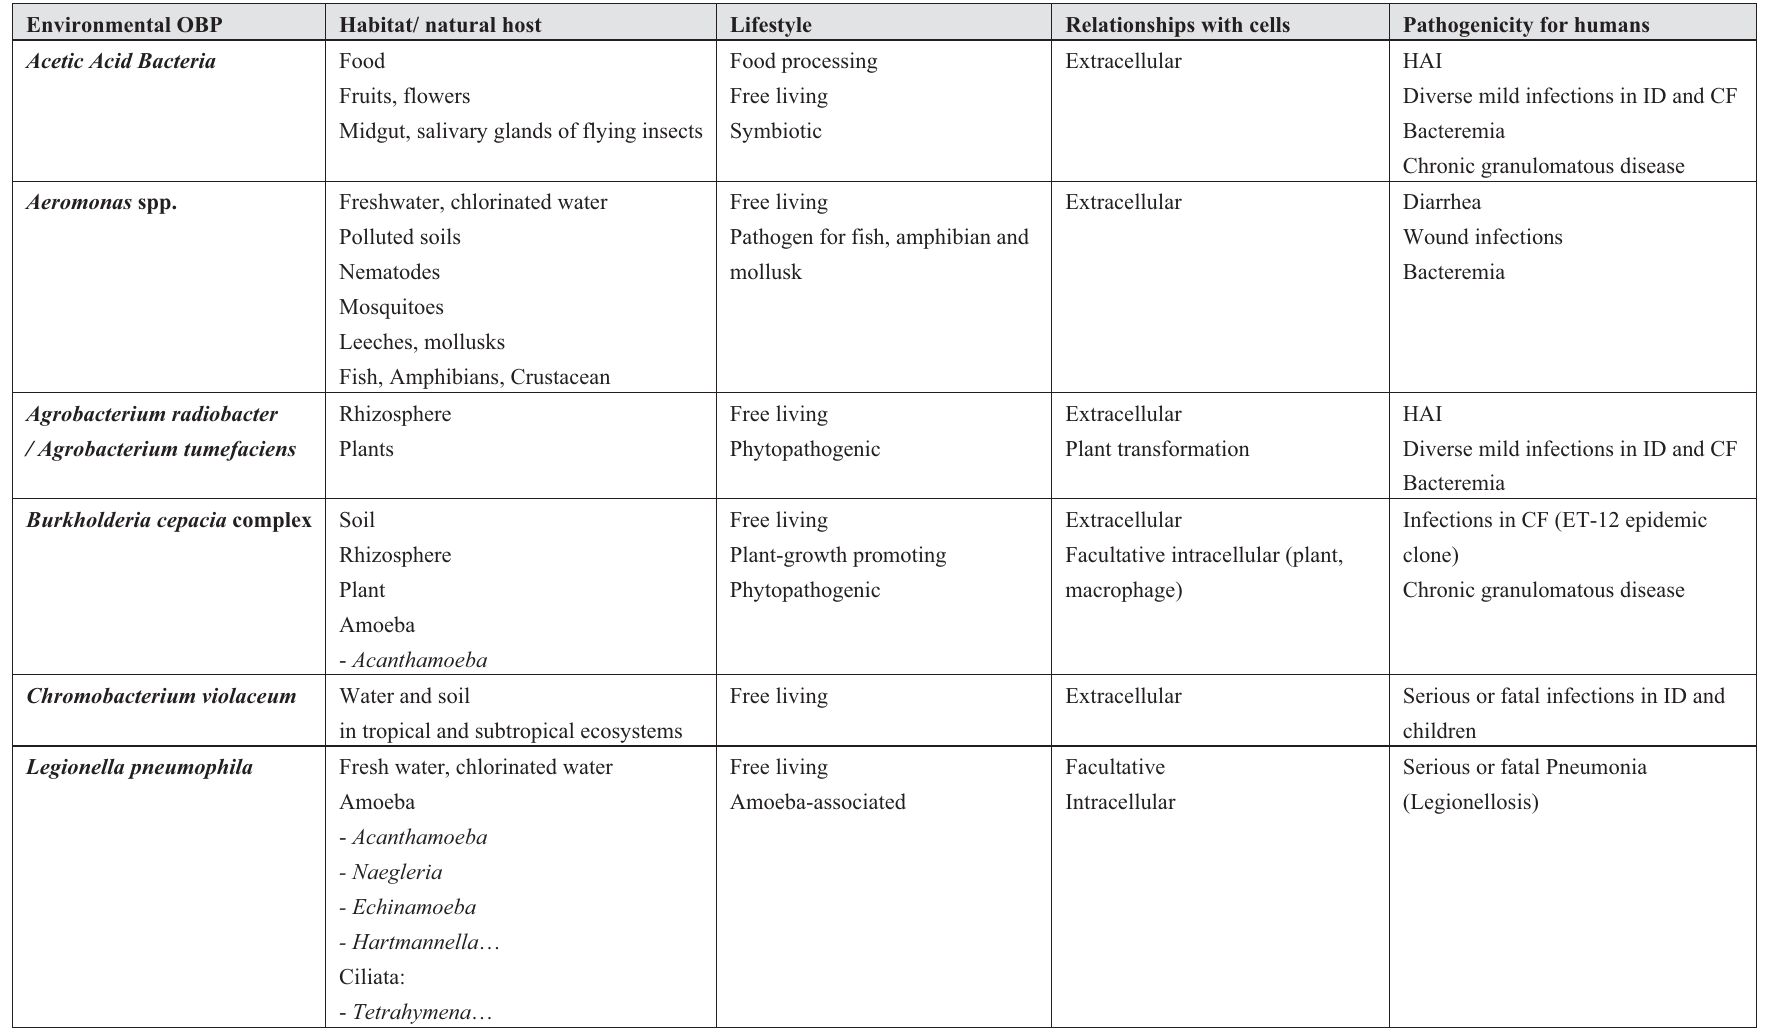
Table 1. Synthetic table showing the major characteristics of the natural behavior of selected environmental OBP. Data were extracted from the references cited in the